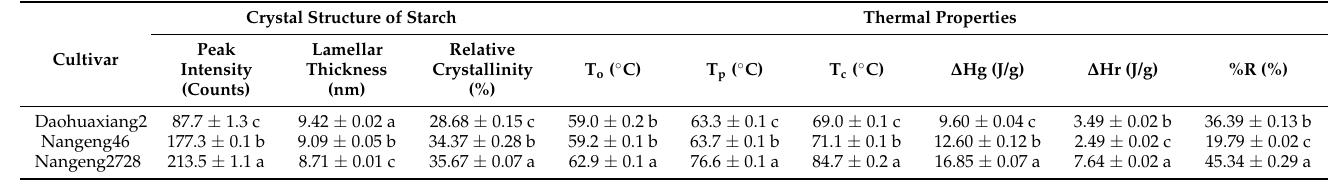
Table 6. Differences of starch crystal structure and thermal properties among different japonica rice. Crystal Structure of Cultivar